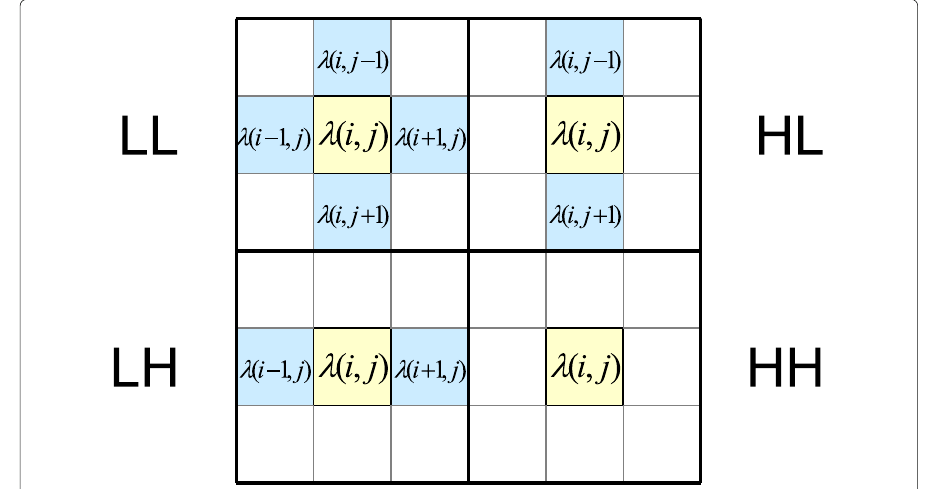
Fig. 4 Predictive side decoding using neighboring vectors in different wavelet